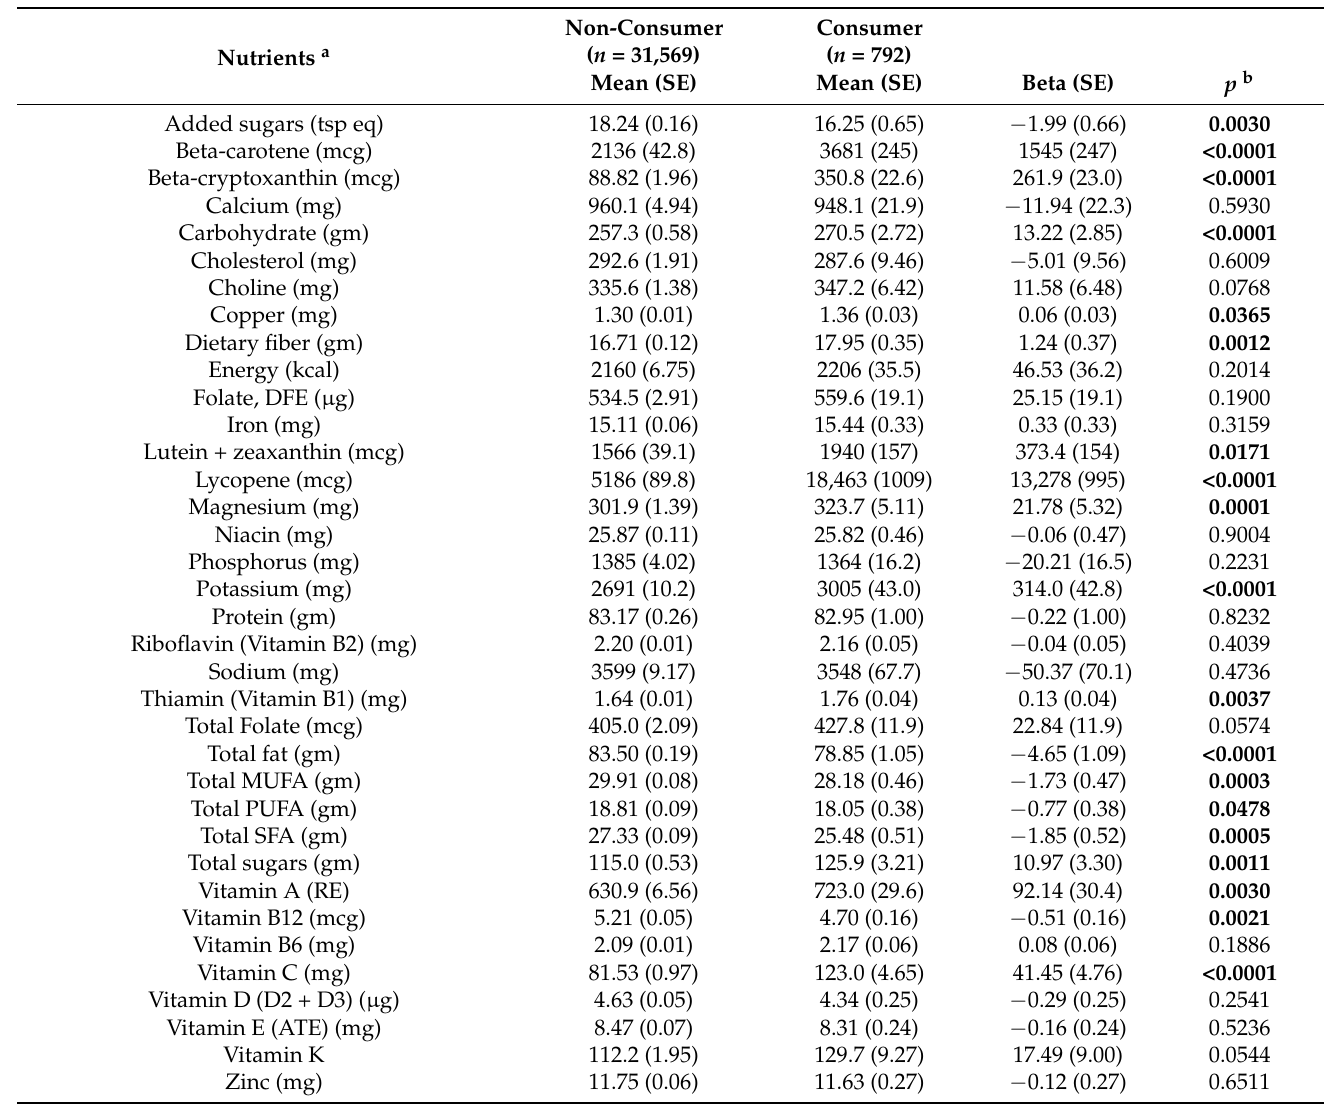
Table 7. Energy and nutrient intakes in adult watermelon consumers ( n = 792) and non-consumers ( n = 31,569), NHANES 2003–2018, gender combined